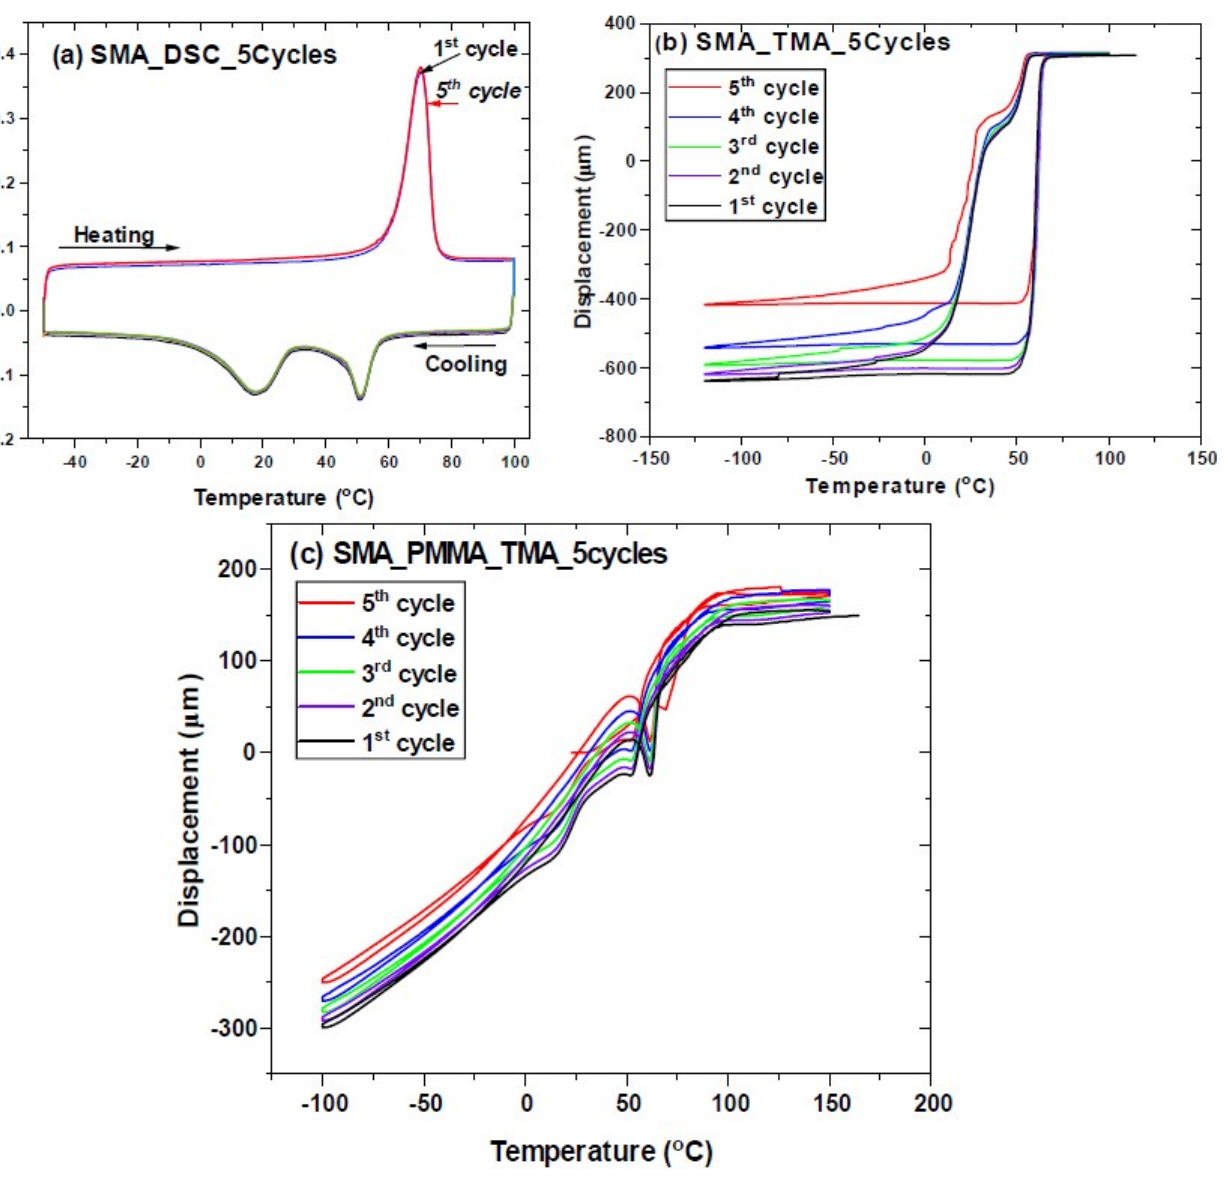
Figure 9. SMA multiple cycles (5th) for ( a ) DSC for SMA–NiTi, ( b ) TMA for SMA–NiTi, and ( c ) TMA for SMA–PMMA composite displacement as function of temperature.